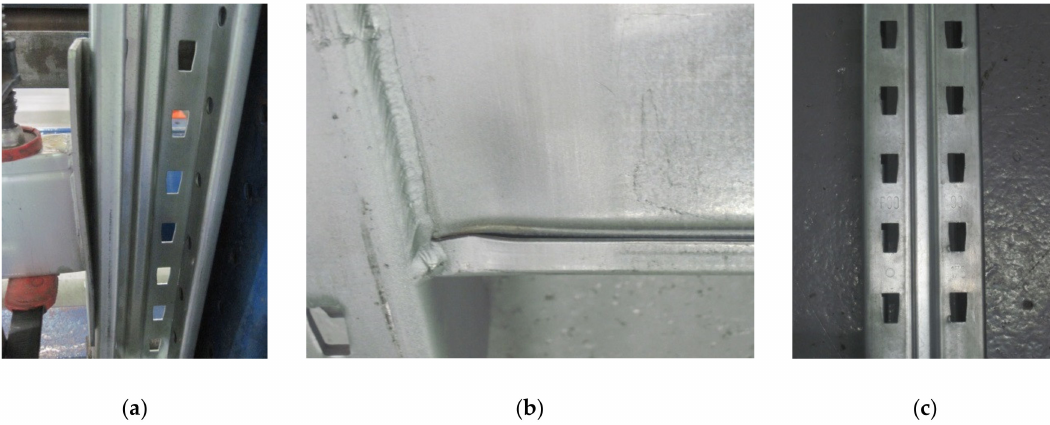
Figure 16. Failure modes in case of the assembly with an upright region having a thickness equal to 1.75 mm: ( a ) failure mode of the connector, ( b ) failure mode of the beam, and ( c ) failure mode of the upright